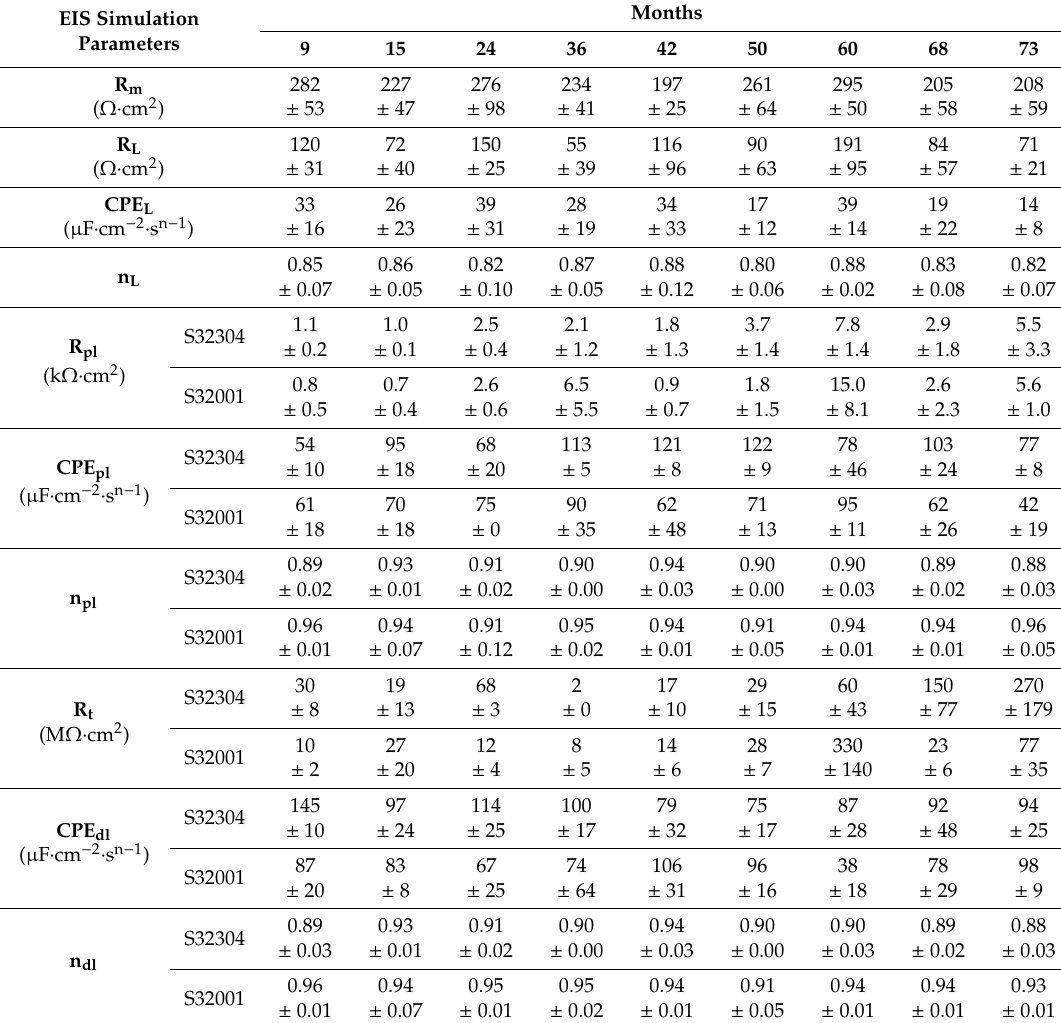
Table 5. Results from simulations of the EIS spectra of reinforced samples tested under HH